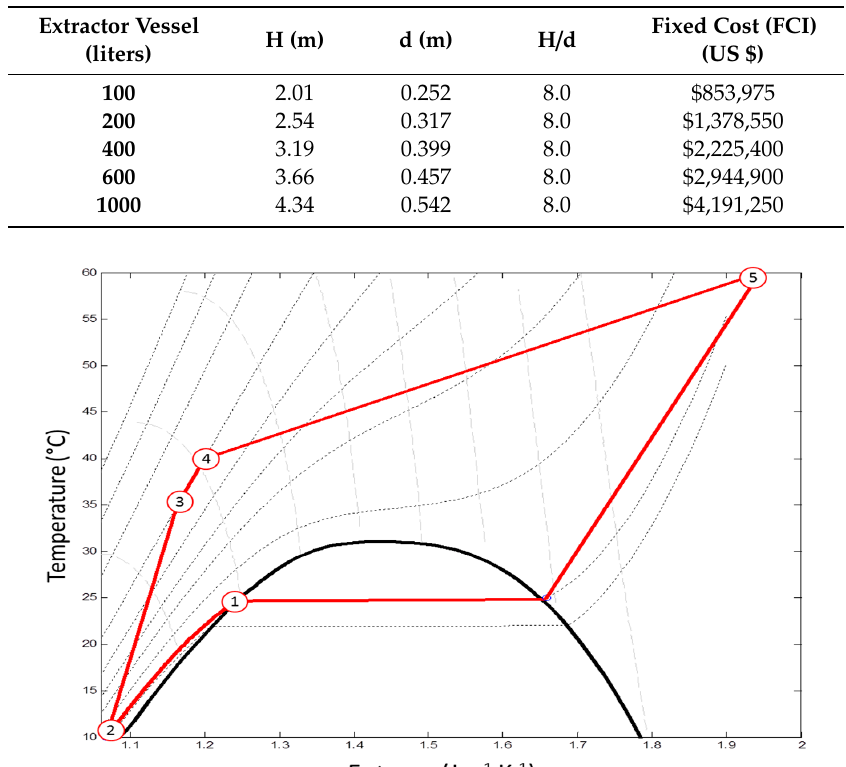
Figure 2. Entropy (s) diagram of CO 2 cycle during supercritical fluid extraction. Circled number 1 represents saturated liquid at 25 ◦ C and 64 bar; 2 is pump inlet (10 ◦ C and 64 bar); 3 is pump exit (35 ◦ C and 220 bar); 4 is extraction vessels (40 ◦ C and 220 bar); 5 is separation vessel (60 ◦ C and 60